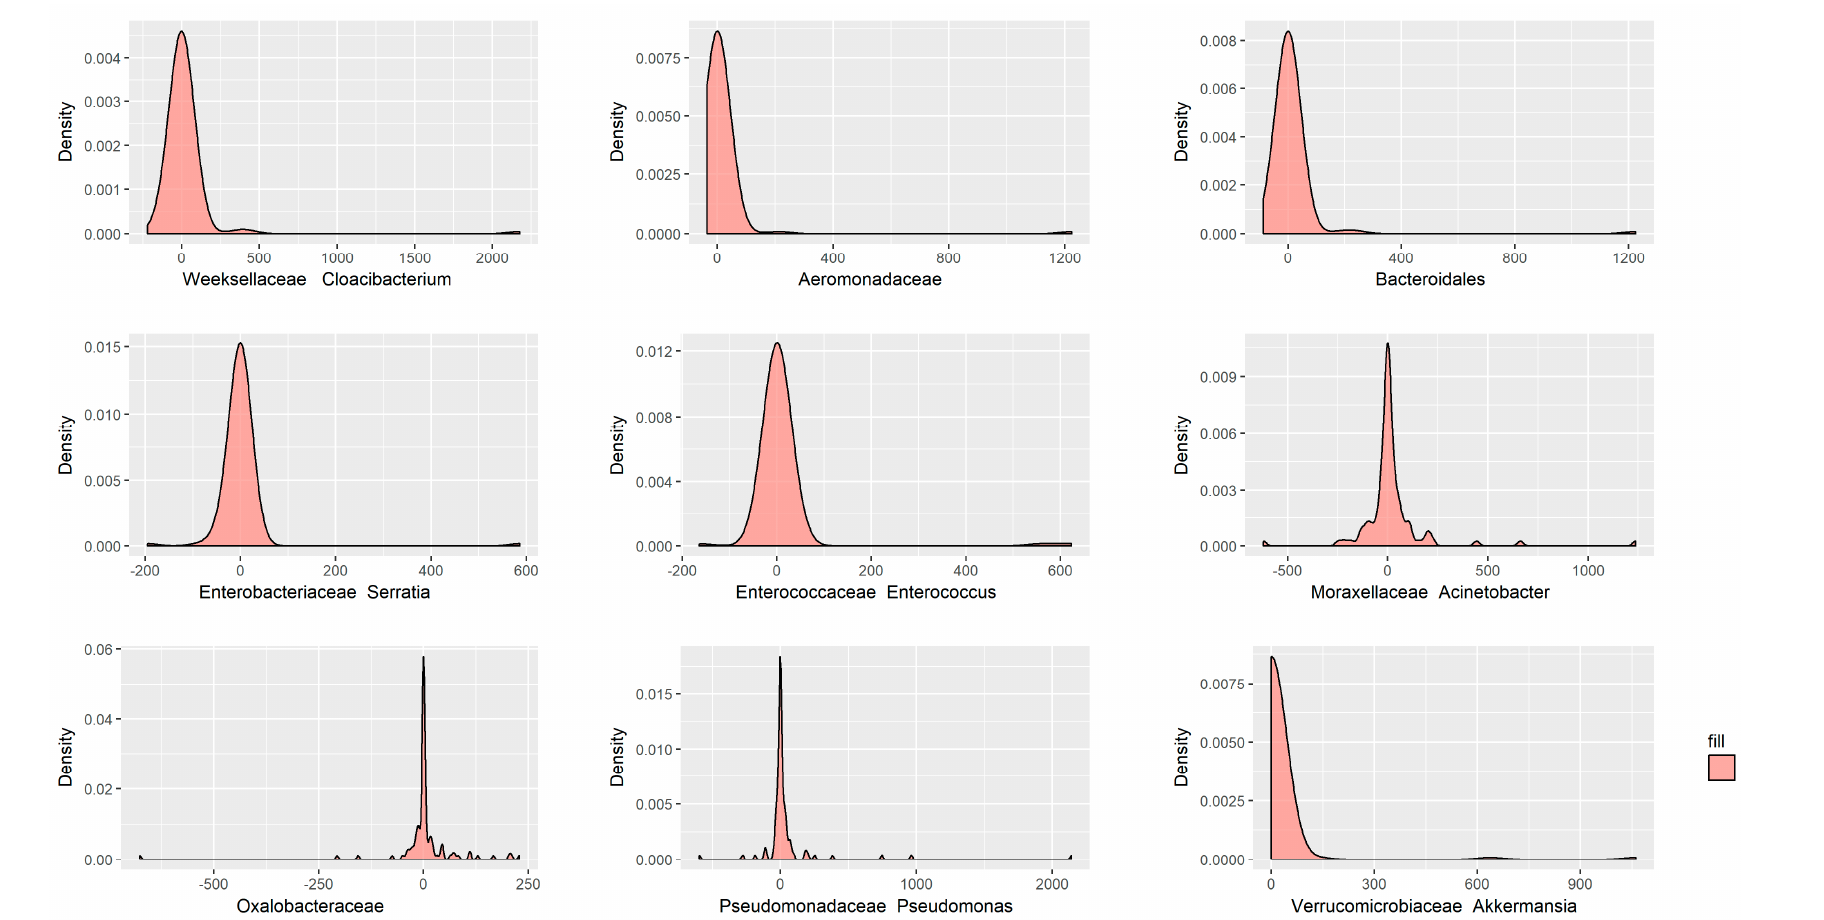
Figure 3. Nine bacterial taxa present a significant correlation both in the blood and ascites, with more than 500 sequence reads.